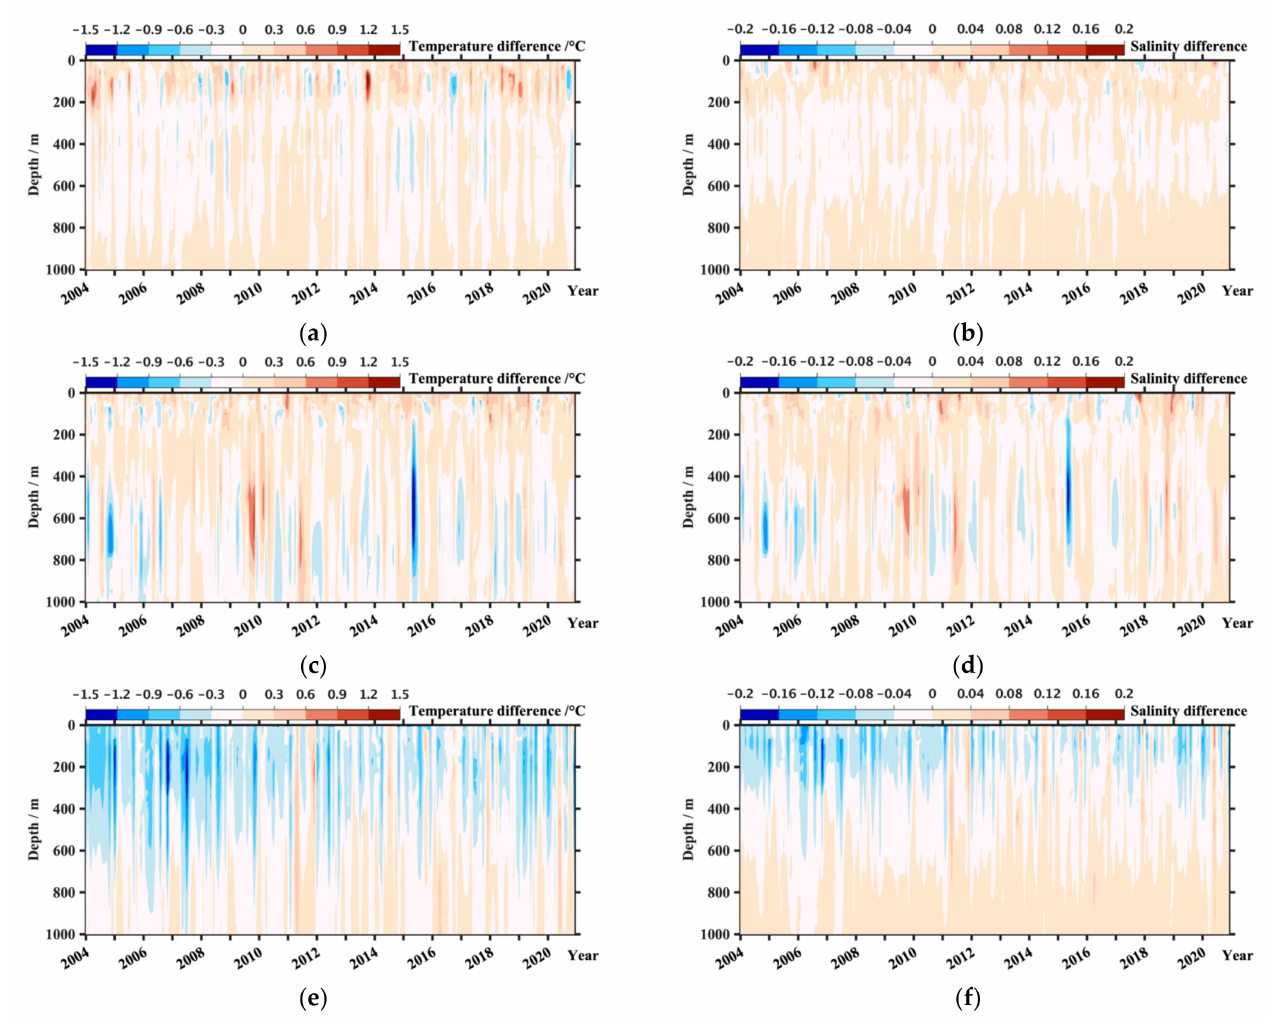
Figure 9. Deviations in temperature and salinity between GDCSM-Argo and RG-Argo gridded datasets. ( a , c , e ) show the temperature differences at points in the Pacific (150 ◦ E, 23 ◦ N), the Atlantic (60 ◦ W, 30 ◦ N), and the Indian (60 ◦ E, 45 ◦ S), respectively. ( b , d , f ) show the corresponding differences in